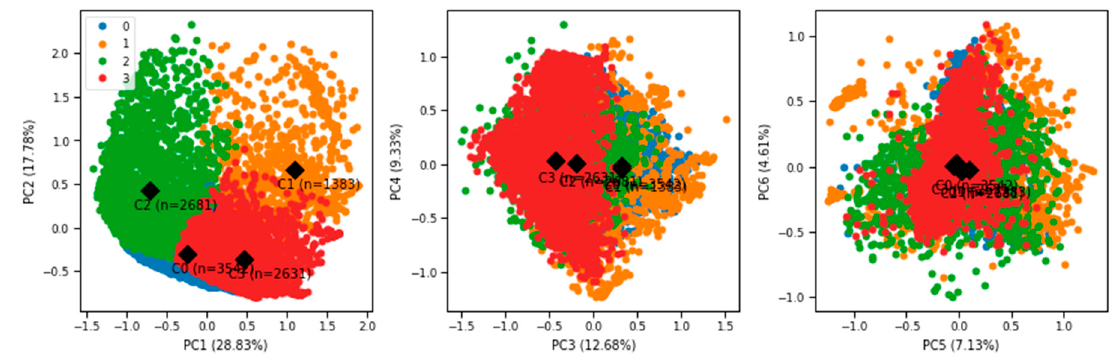
Figure 7. Cluster solution with six principal components. Table 7. The four clusters, characterised by the three principal components.